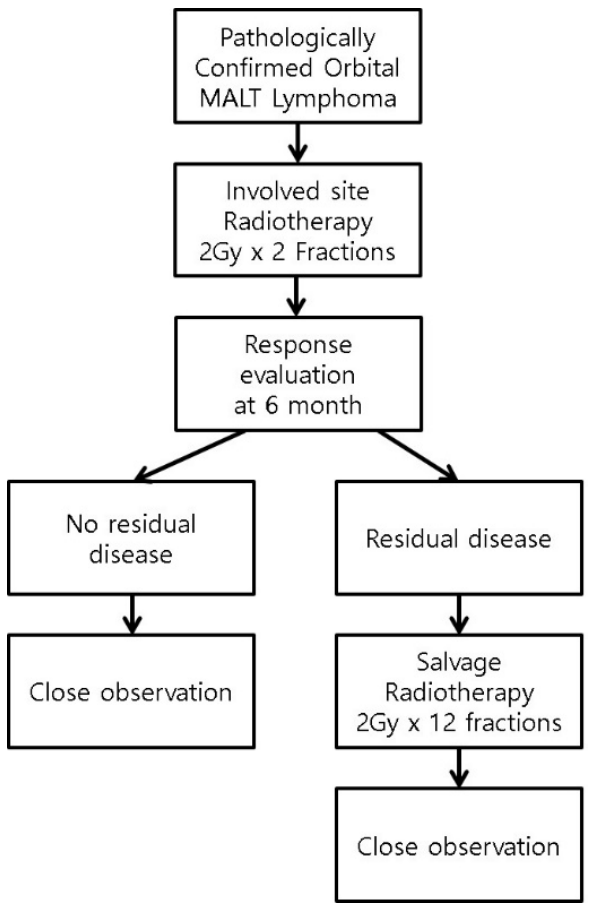
Figure 1. Image showing the treatment protocol.